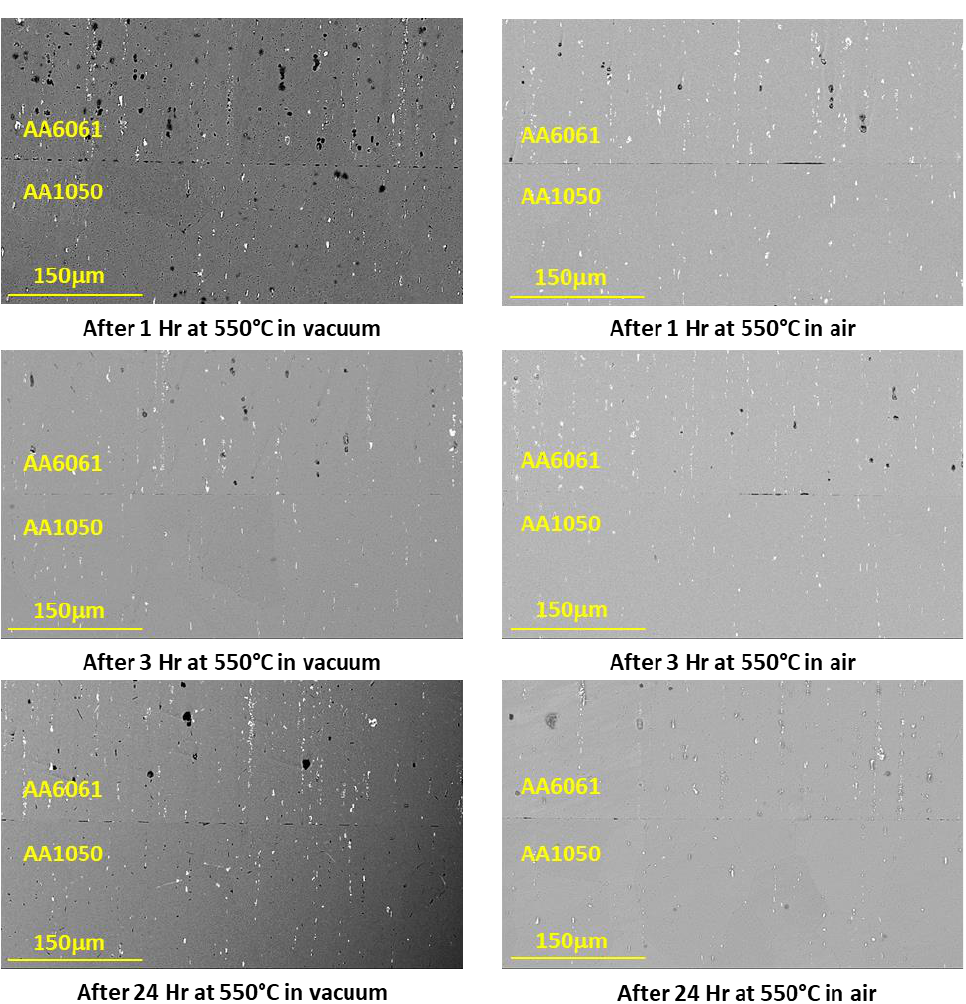
Figure 12. Typical interface of AA6061–AA1050 pairs after diffusion bonding experiment for different holding times and atmosphere.